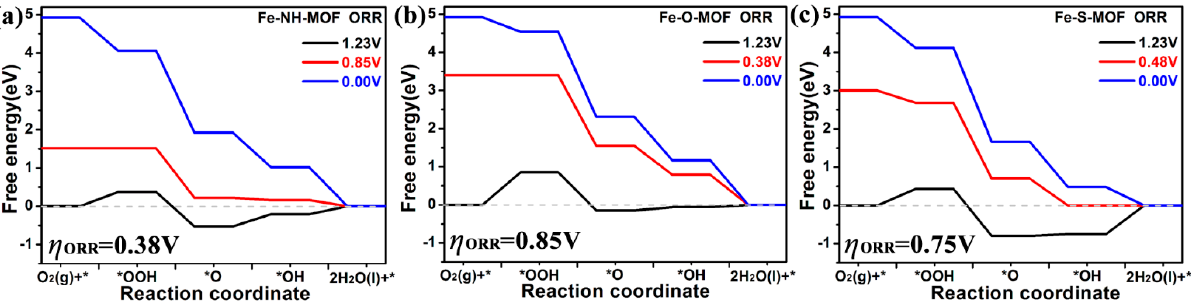
Figure 7. Calculated free energy diagram for hydrogen evolution on ( a ) Fe-NH-MOF, ( b ) Fe-O- MOF, and ( c ) Fe-S-MOF monolayers at a potential U = 0, 1.23, and working potentials relative to the standard hydrogen electrode at pH = 0.